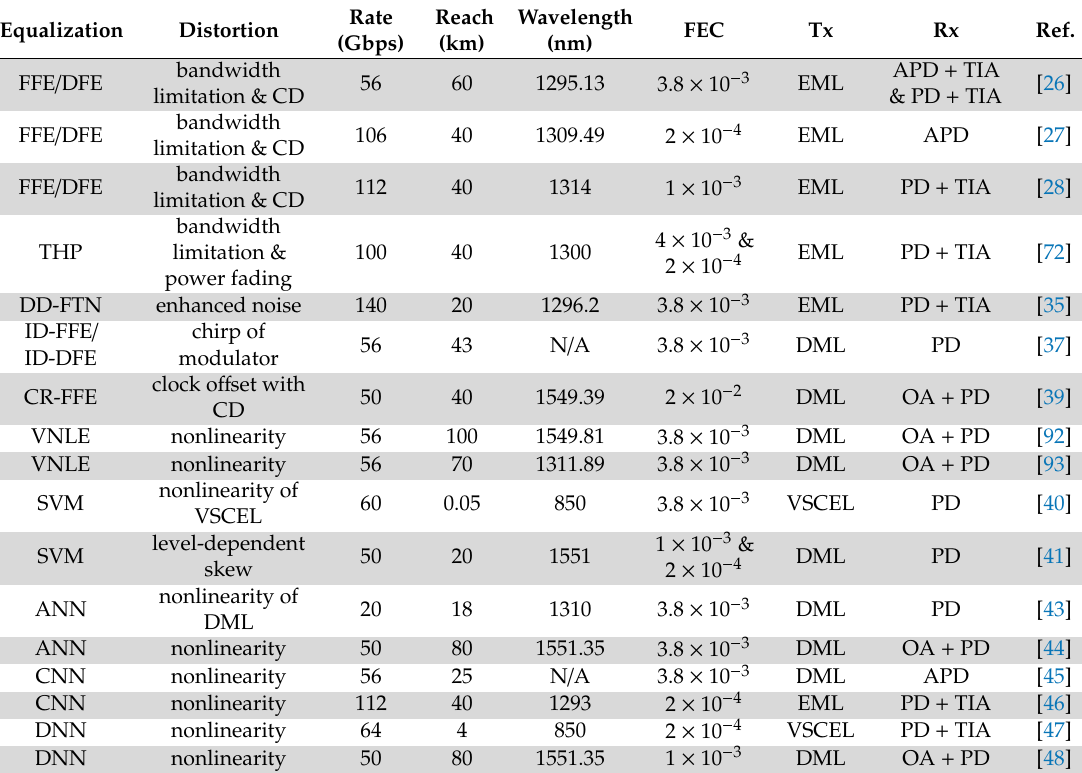
Table 3. Equalization technologies for short-reach PAM4 optical links.